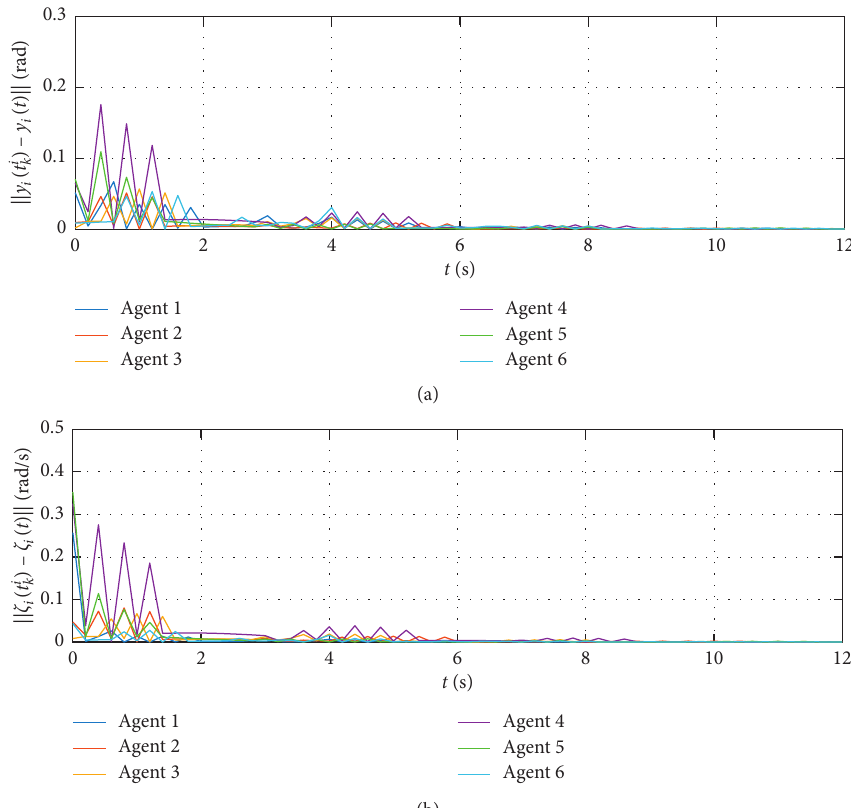
Figure 4: Simulation results of circle formation for second-order MASs. (a) The evolution of y (b) The sequence of event-triggered times for i � 1 , 2 , ... , N when h � 0 .